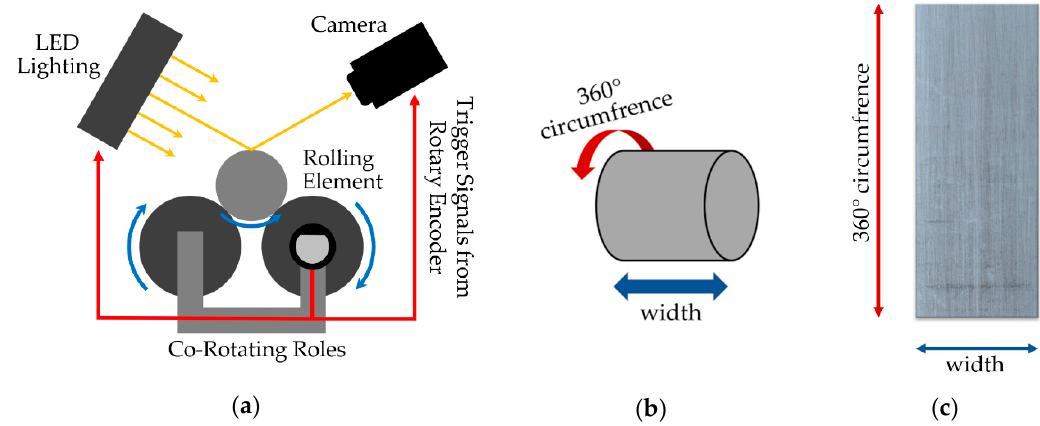
Figure 1. ( a ) A schematic side view of the hardware setup used for scanning the rolling elements. ( b ) and ( c ) indicate how the resulting surface scan images of size 1395 px by 3335 px correspond to the rolling element parts they originate from.